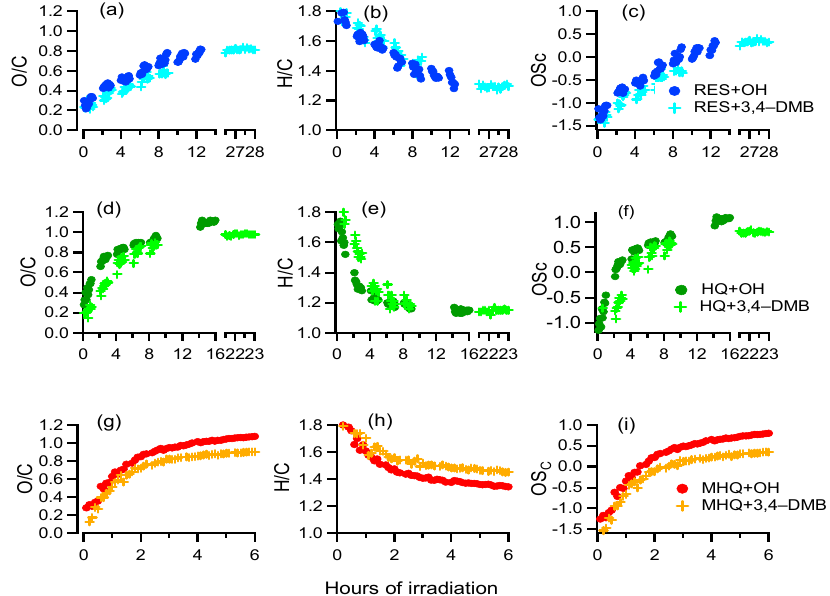
Figure 5. ( a , d , g ) O/C of aqueous-phase products, ( b , e , h ) H/C of aqueous-phase products, and ( c , f , i ) OS c of aqueous-phase products as a function of time during different experiments.